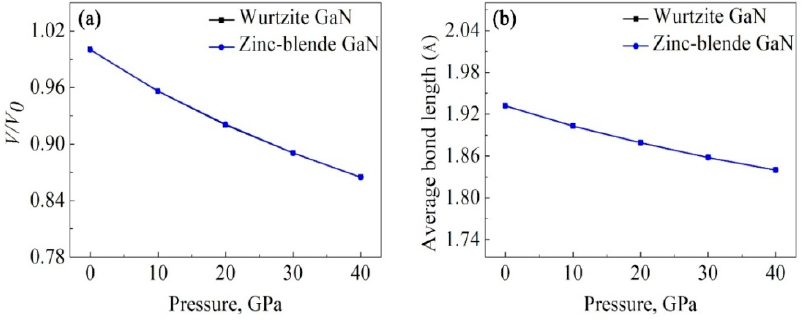
Figure 2. Calculated pressure dependences of V / V 0 ( a ) and average Ga-N bond lengths ( b ). Table 1. Lattice parameters at zero pressure.